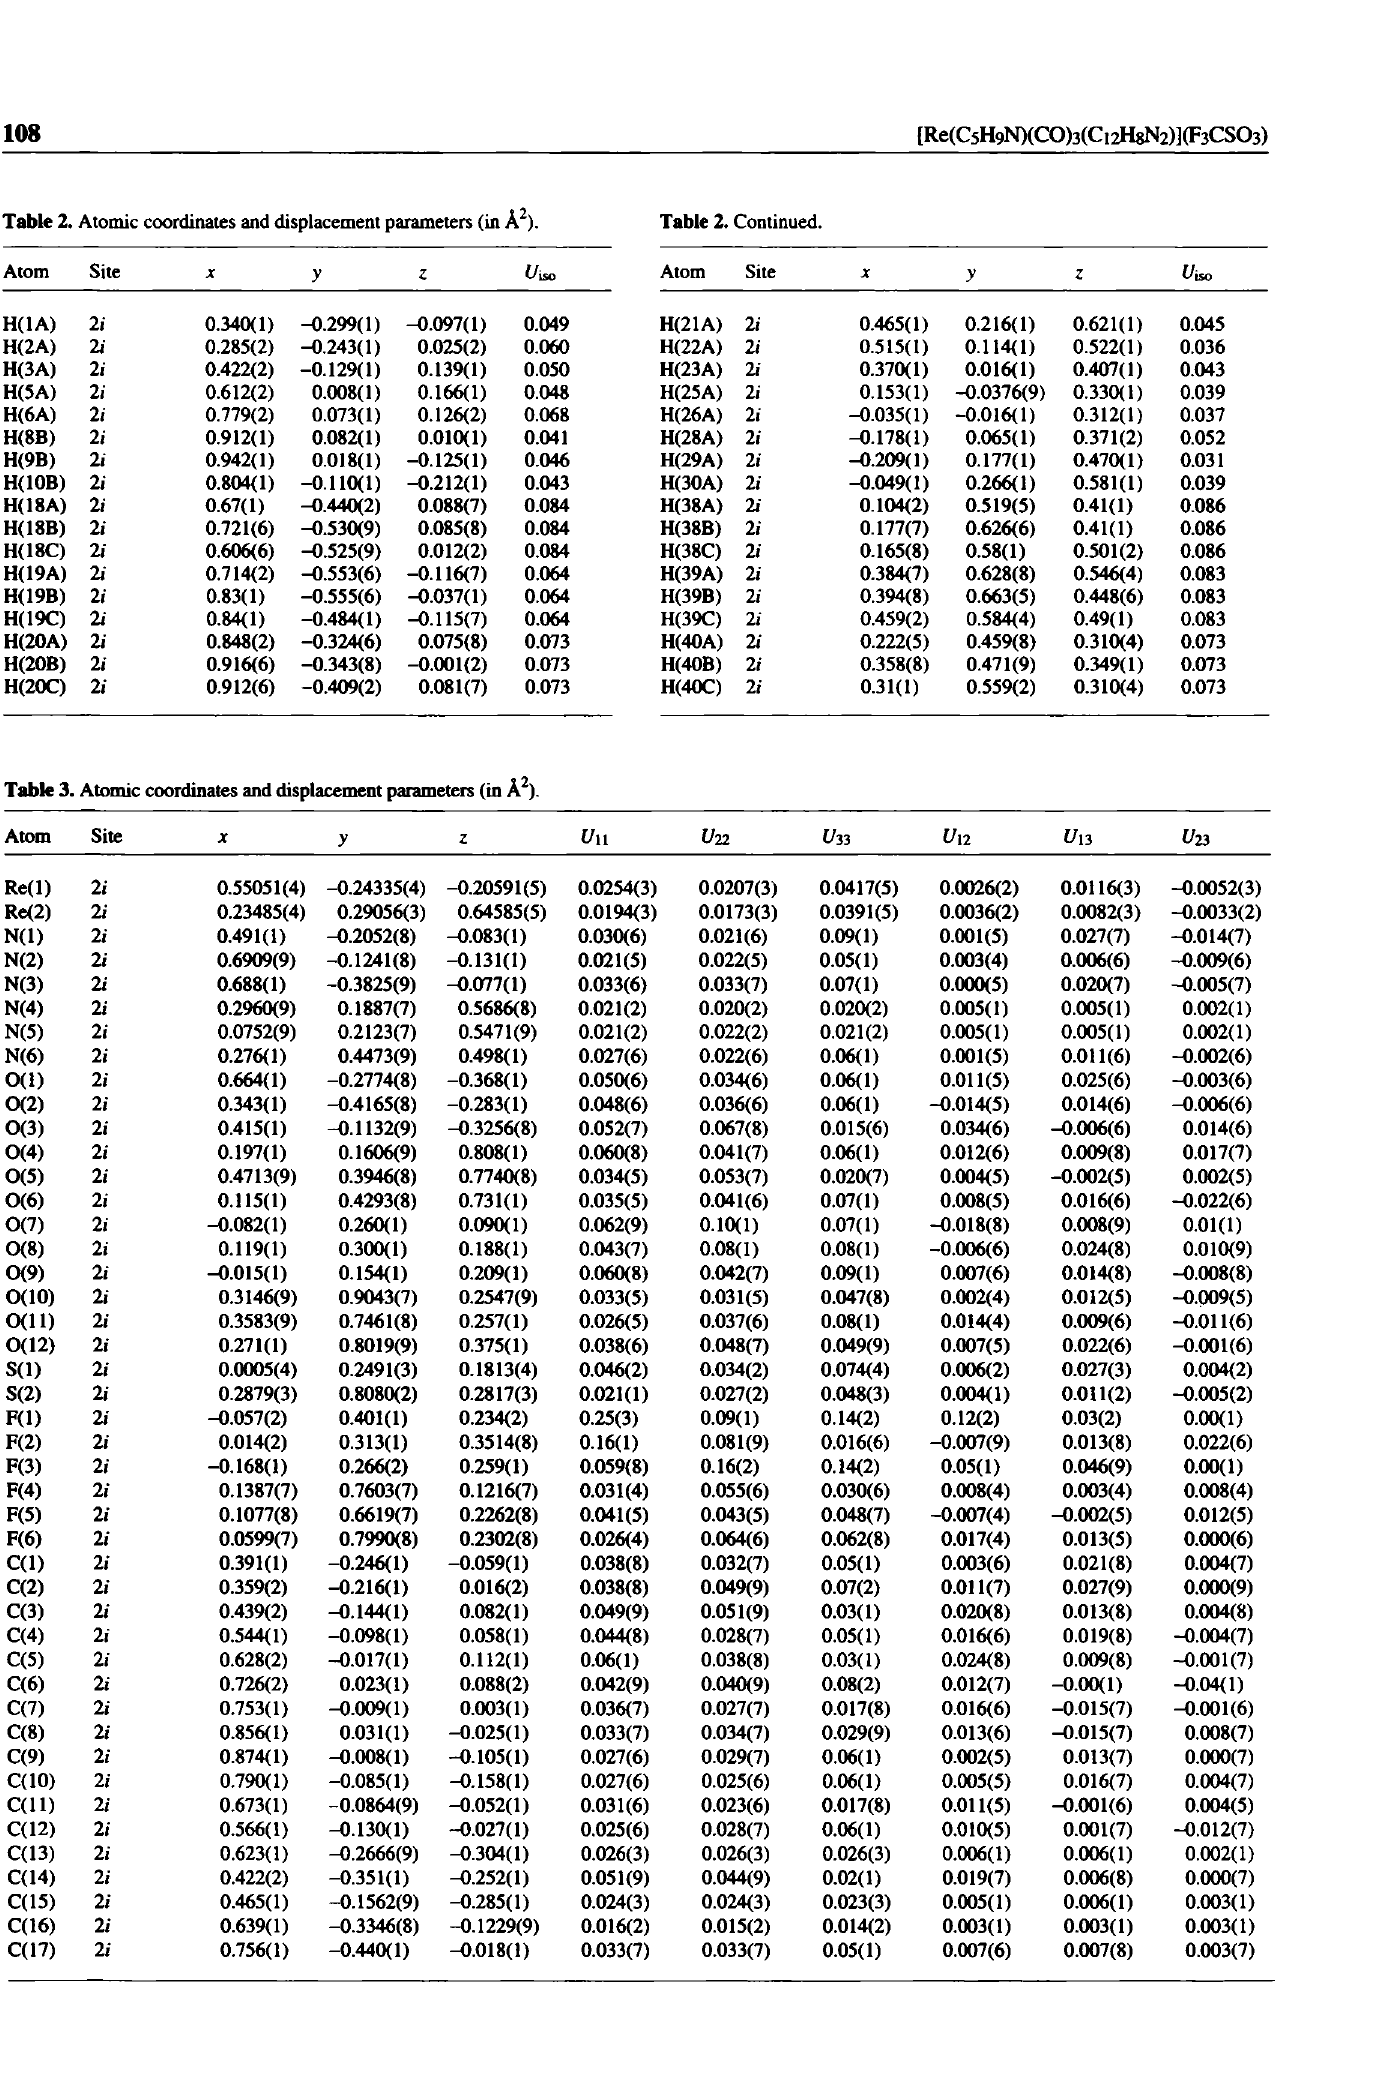
Table 3. Atomic coordinates and displacement parameters (in A 2